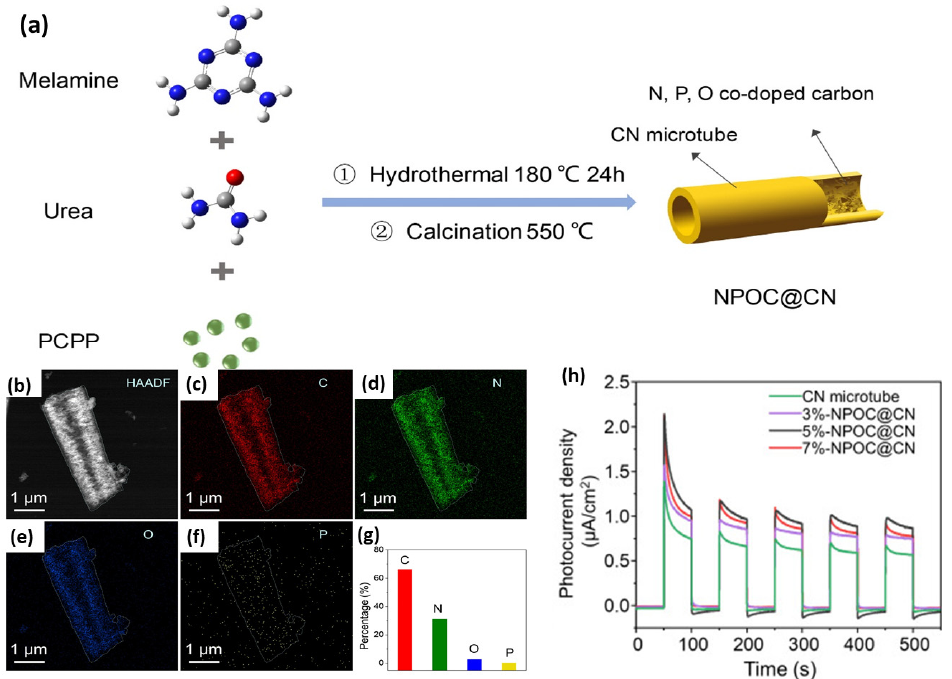
Figure 13. ( a ) The formation process, ( b ) HAADF-STEM, ( c – g ) EDX mapping of 5%-NPOC@CN. ( h ) transient photocurrent responses on 5%-NPOC@CN relative to its counterparts. Adapted with per- mission from Ref. [162]. 2022, Elsevier Inc.